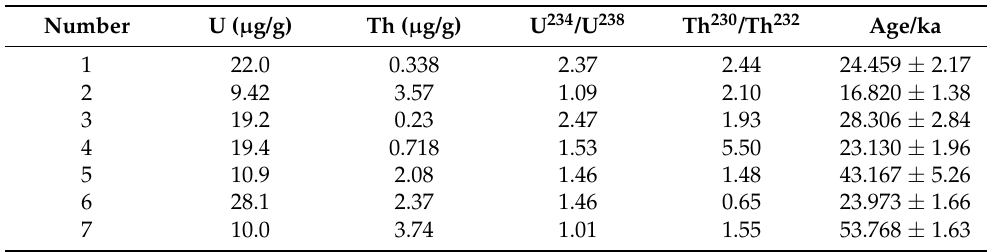
Table 4. Dating analysis results of travertine uranium series of carbonated thermal water springs in Qijiachuan, Ping’an County (according to